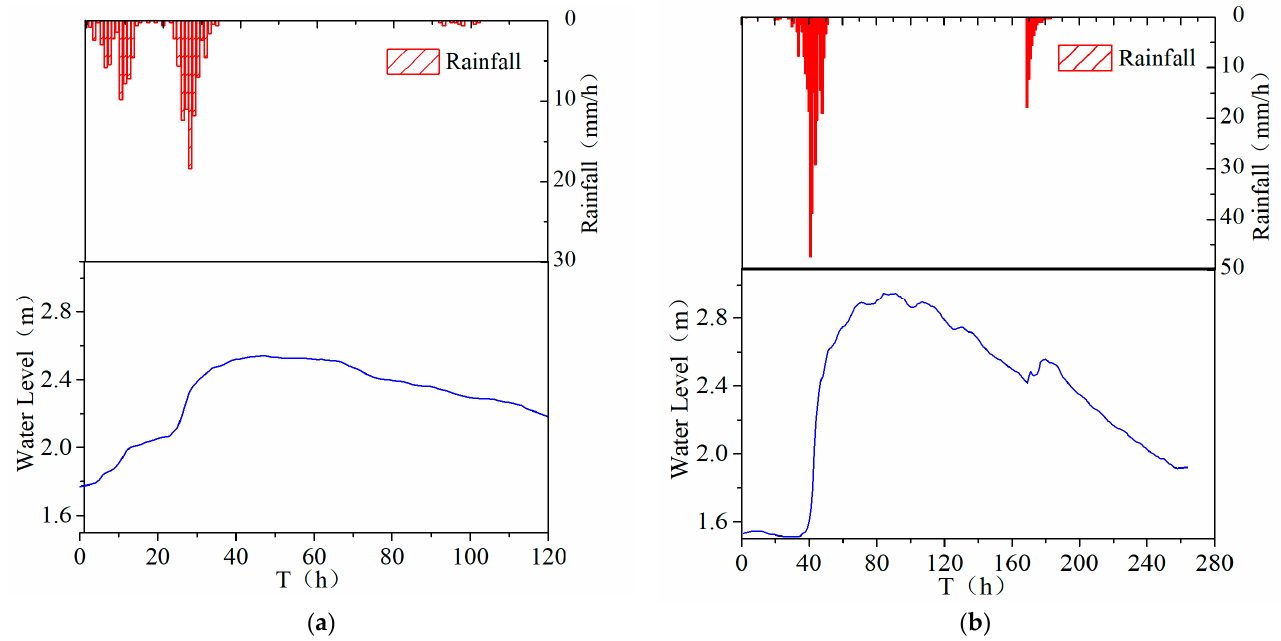
Figure 6. Process of rainfall and river water level change in Gaoyou Irrigation Area. ( a ) Rain fall Event1(from 3:00 on 13 August to 3:00 on 18 August 2014) ( b ) Rain fall Event2 (from 10:00 on 9 August to 2:00 on 21 August 2015).